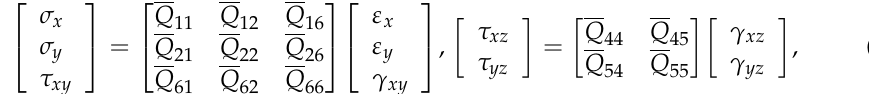
Figure 2. The plane-stress state. For a unified formulation for each layer, Equation (1) should be transformed into the plate (laminate) coordinate system as